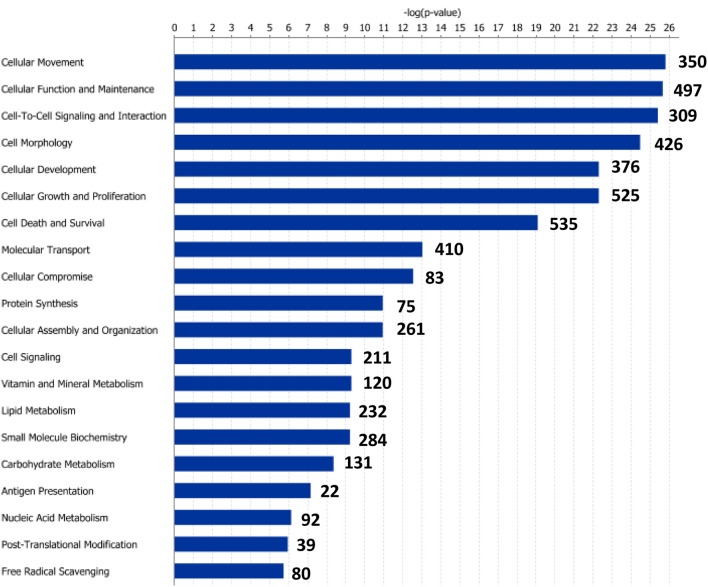
Molecular and cellular functions of differentially expressed genes in the posterior intestine segment (PI). For a given molecular function, blue bars indicate the −log of the P-value, and the number of differentially expressed genes is represented.